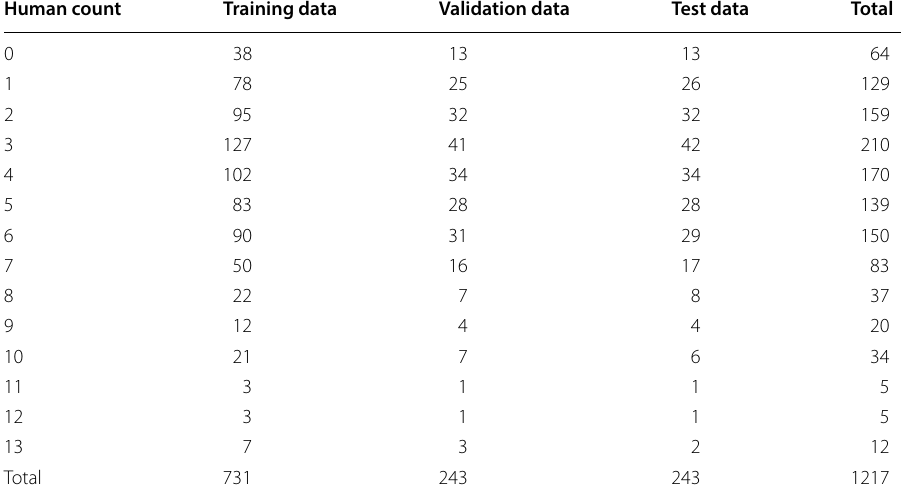
Table 1 Data distribution